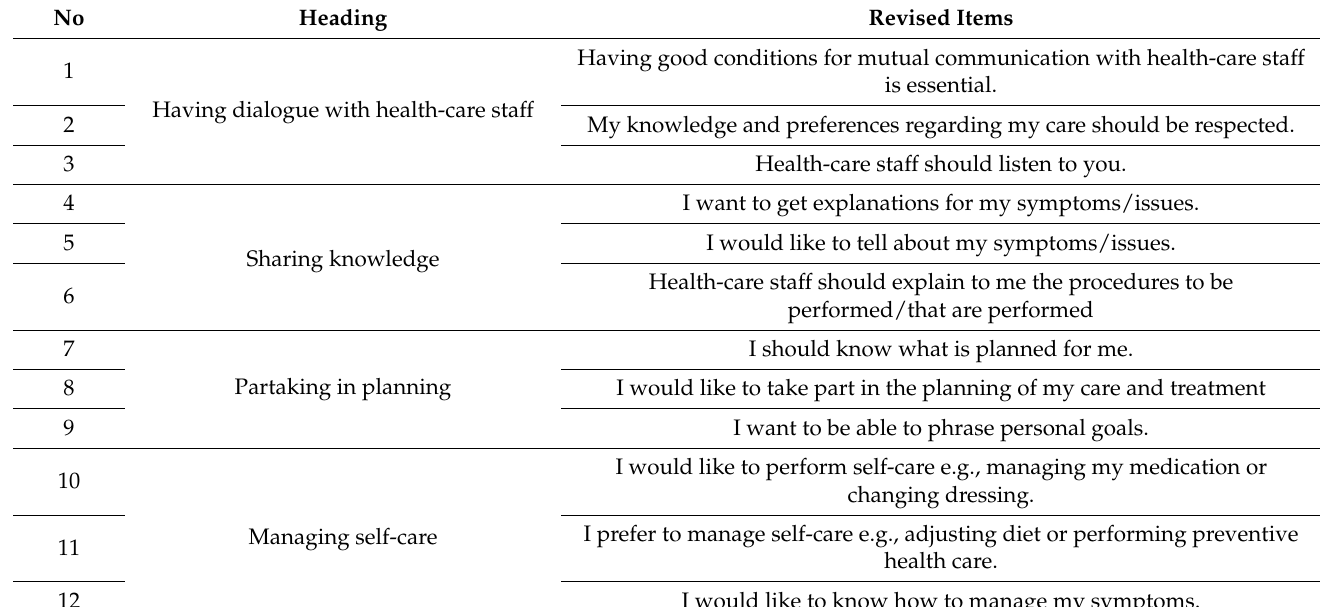
Table 1. The items conceptualizing citizen participation used in this